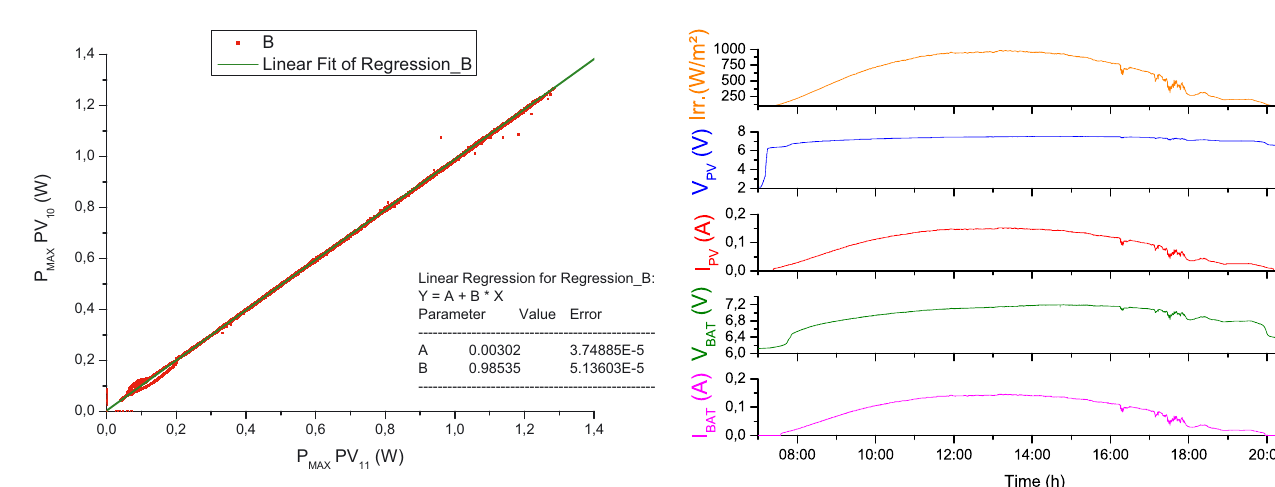
Fig. 15. Maximum output power of panel 10 as a function of the power of panel 11.